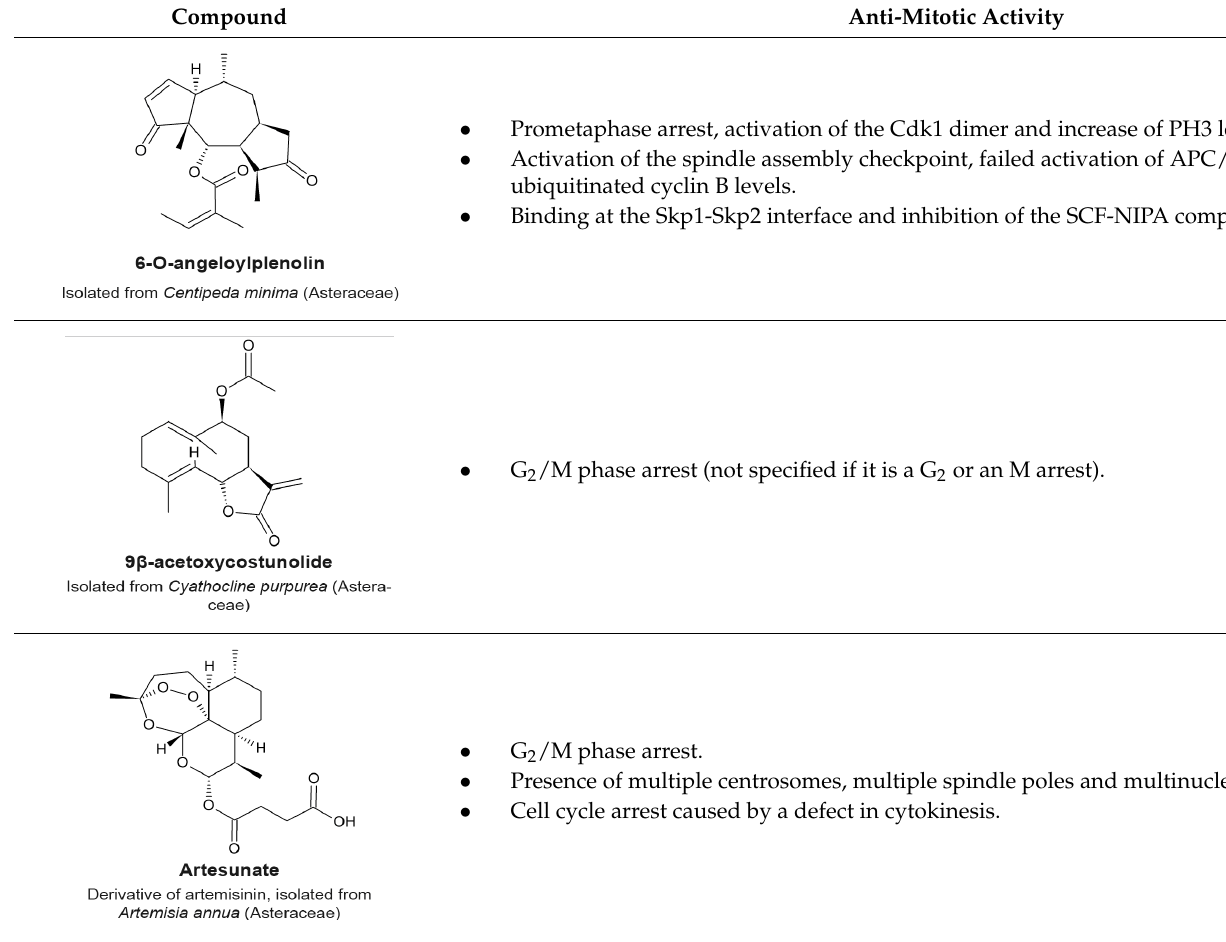
Table 3. The names and structures of sesquiterpenes that have cell cycle arrest or mitotic activity are given.